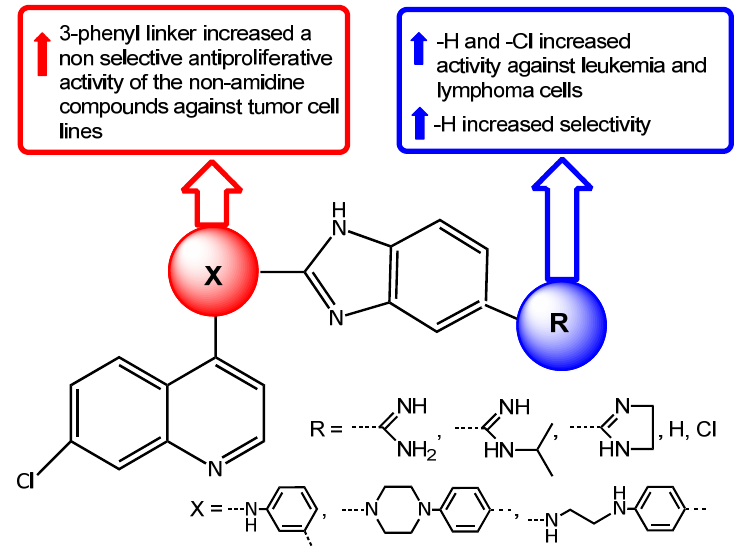
Figure 2. Structure activity relationship for antiproliferative activity of the 7-chloro-4-aminoquinoline–benzimidazole compounds.